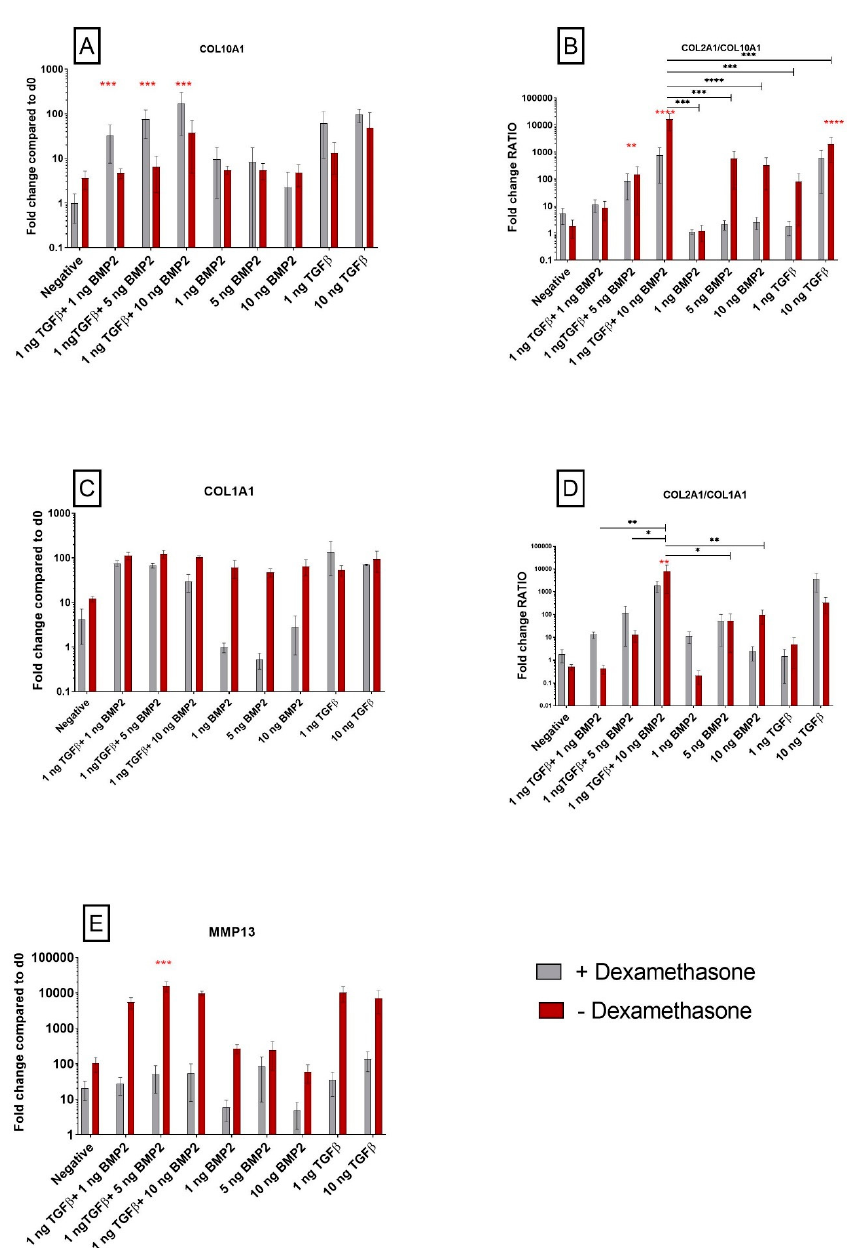
Figure 2. Dexamethasone modulates COL10A1 expression, a hypertrophy marker, in hSDSCs exposed to TGF- β 1 and BMP-2. Cells were cultured for 21 days in the presence of 10 ng / mL TGF- β 1 (positive control) or in its absence (negative), low TGF- β 1 concentration (1 ng / mL TGF- β 1), di ff erent concentrations of BMP-2 alone (1 ng / mL BMP-2, 5 ng / mL BMP-2, 10 ng / mL BMP-2) or BMP-2 in combination with TGF- β 1 (1 ng / mL TGF- β 1 + 1 ng / mL BMP-2, 1 ng / mL TGF- β 1 + 5 ng / mL BMP-2 and 1 ng / mL TGF- β 1 + 10 ng / mL BMP-2). The amounts of COL10A1 ( A ), COL1A1 ( C ) and MMP13 ( E ) mRNAs were normalized to RPLP0 . The ratio between COL2A1 and COL10A1 ( B ) and COL2A1 and COL1A1 ( D ) was calculated as the ratio between the fold change of each gene. The levels of gene expression of cells exposed to di ff erent media in the presence or absence of 100 nM dexamethasone were plotted as a fold change relative to the expression of the corresponding gene in undi ff erentiated cells (hSDSC day 0) defined as 1 (mean ± SD; n = 4). Grey bars represent scatterplot of di ff erent measurement in hSDSC exposed to dexamethasone, red bars represent scatterplot of di ff erent measurement in hSDSC not exposed to dexamethasone. Data are expressed as mean ± SD, significant di ff erence from dexamethasone treatment in the same group is marked by red asterisks; significant di ff erence among group is marked by black asterisks (* p ≤ 0.05, ** p ≤ 0.01, *** p ≤ 0.001, **** p ≤